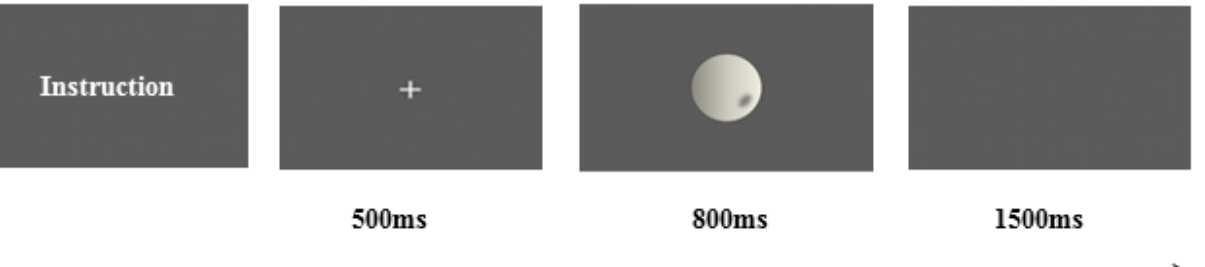
Figure 2. This is a flow-process diagram for a sample trial; when the 3D picture composed of white ball and hitting location (black shade point) appeared, the participants were instructed to identify as quickly and accurately as possible whether the current picture could represent a side-backspin serve or not and press the “Enter” key in the keyboard or not.